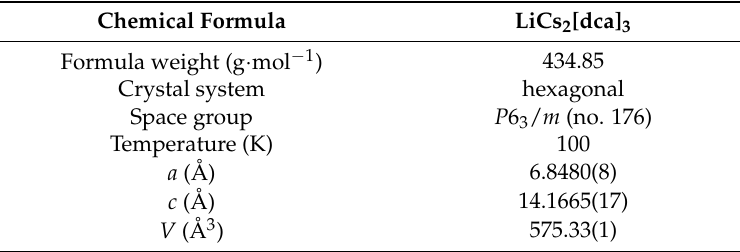
Table 3. Crystallographic data of LiCs 2 [dca] 3